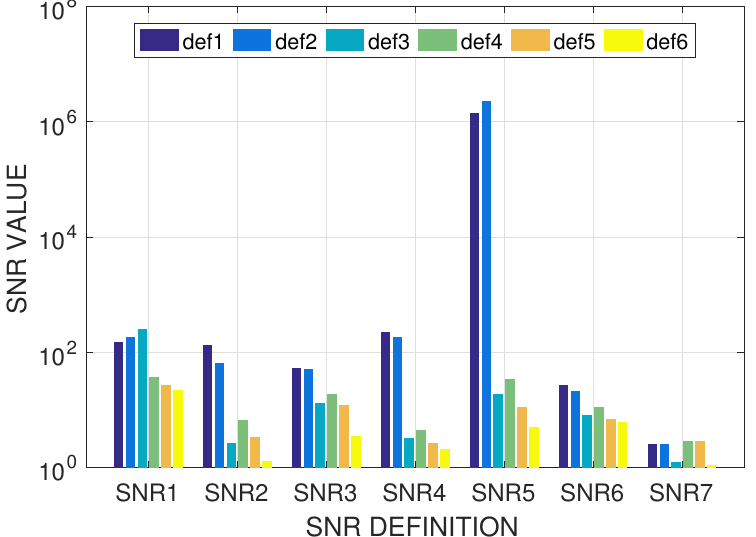
Figure 14. Average SNR values obtained with the different SNR metric definitions for the ana- lyzed